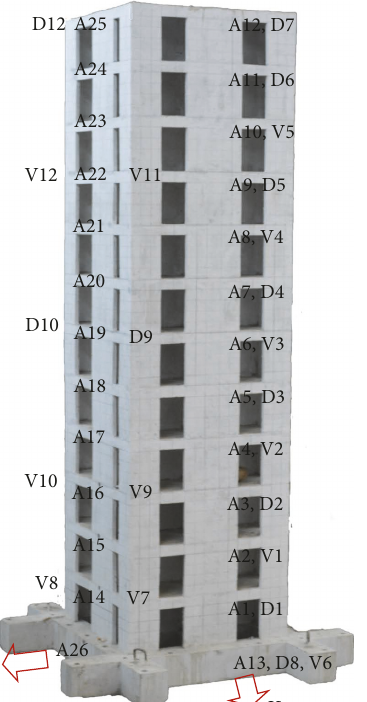
Figure 4: Arrangement of accelerometers, displacement transduc- ers, and velocity vibration sensors.